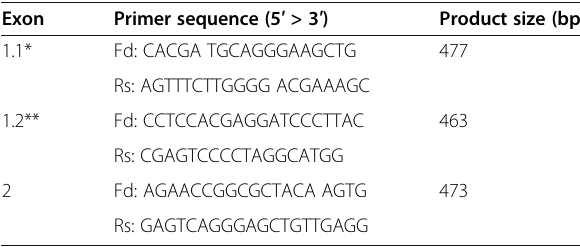
Table 1 Features of primer pairs used for the NKX2.5